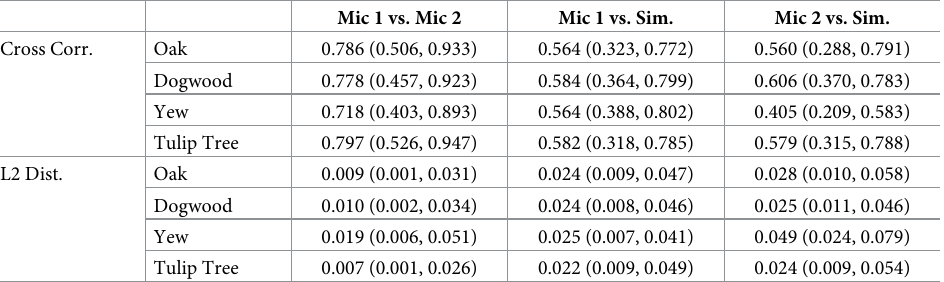
Cross Corr: the maximum absolute value of normalized cross correlation; L2 Dist: the L2 distances of single sided amplitude spectra; Mic 1: signal from microphone 1; Mic 2: signal from microphone 1; Sim: the simulated